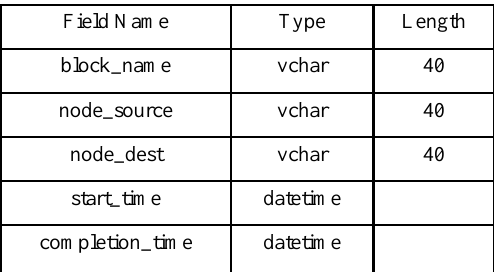
Figure 5. Four point blocks for interpolation